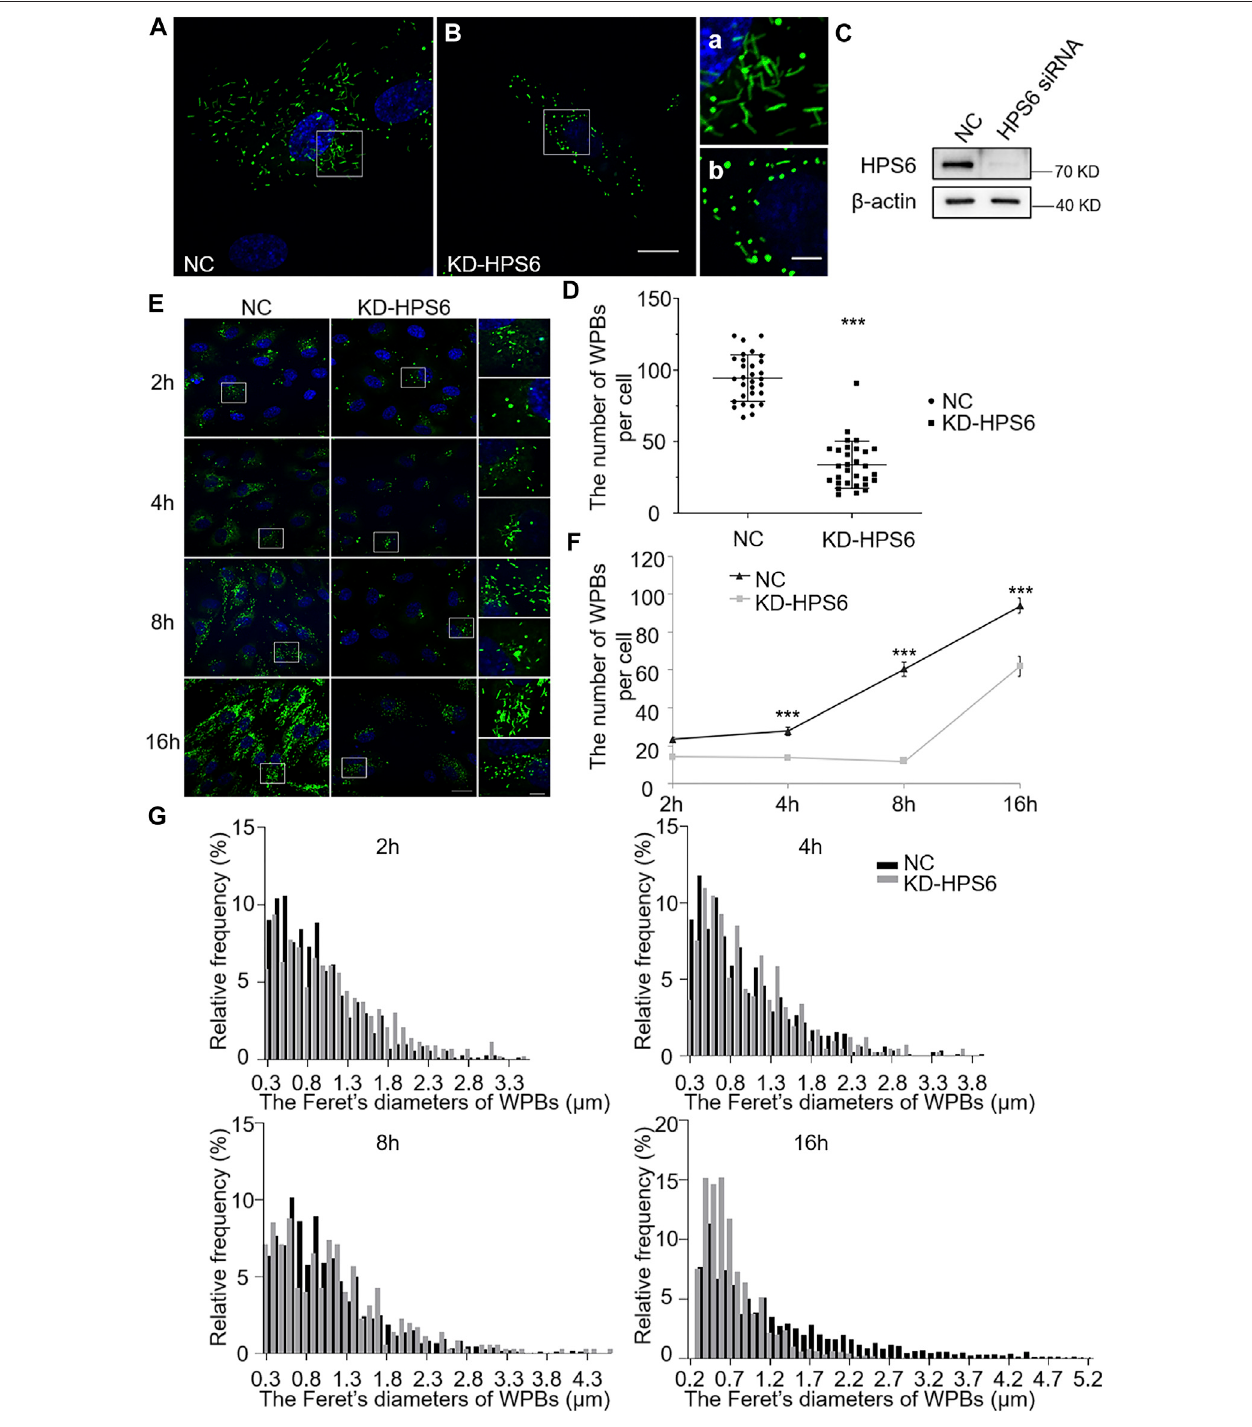
FIGURE 2 | The number and the elongated shape of newly formed Weibel – Palade bodies (WPBs) are affected in KD-HPS6 human umbilical vein endothelial cells (HUVECs).( A , B )Immuno fl uorescenceimagesofnegativecontrol(NC; A )andHPS6(KD-HPS6; B )siRNA-mediatedknockdowninHUVECslabeledagainstvWF(green) and nucleus (DAPI, blue). Moreover, 80 nM PMA was added to each dish to stimulate WPB secretion for 30 min, and the cells were fi xed at 2, 4, 8, and 16 h after washing out. Scale bar, 20 μ m. The boxed square in ( A , B ) was magni fi ed as (a, b) respectively. Scale bar, 5 μ m. ( C ) Western blotting analysis of the detection of HPS6 knockdown.( D )QuantitativeanalysisofthenumberofWPBspercellofNCandKD-HS6HUVECs( n =30,*** p < 0.001).( E )BothNCandKD-HPS6HUVECswere exposedto80 nMPMAfor30 mintostimulateWPBsecretion,andthecellswere fi xedat2,4,8,and16 h,respectively,afterwashingout.Immuno fl uorescenceimages